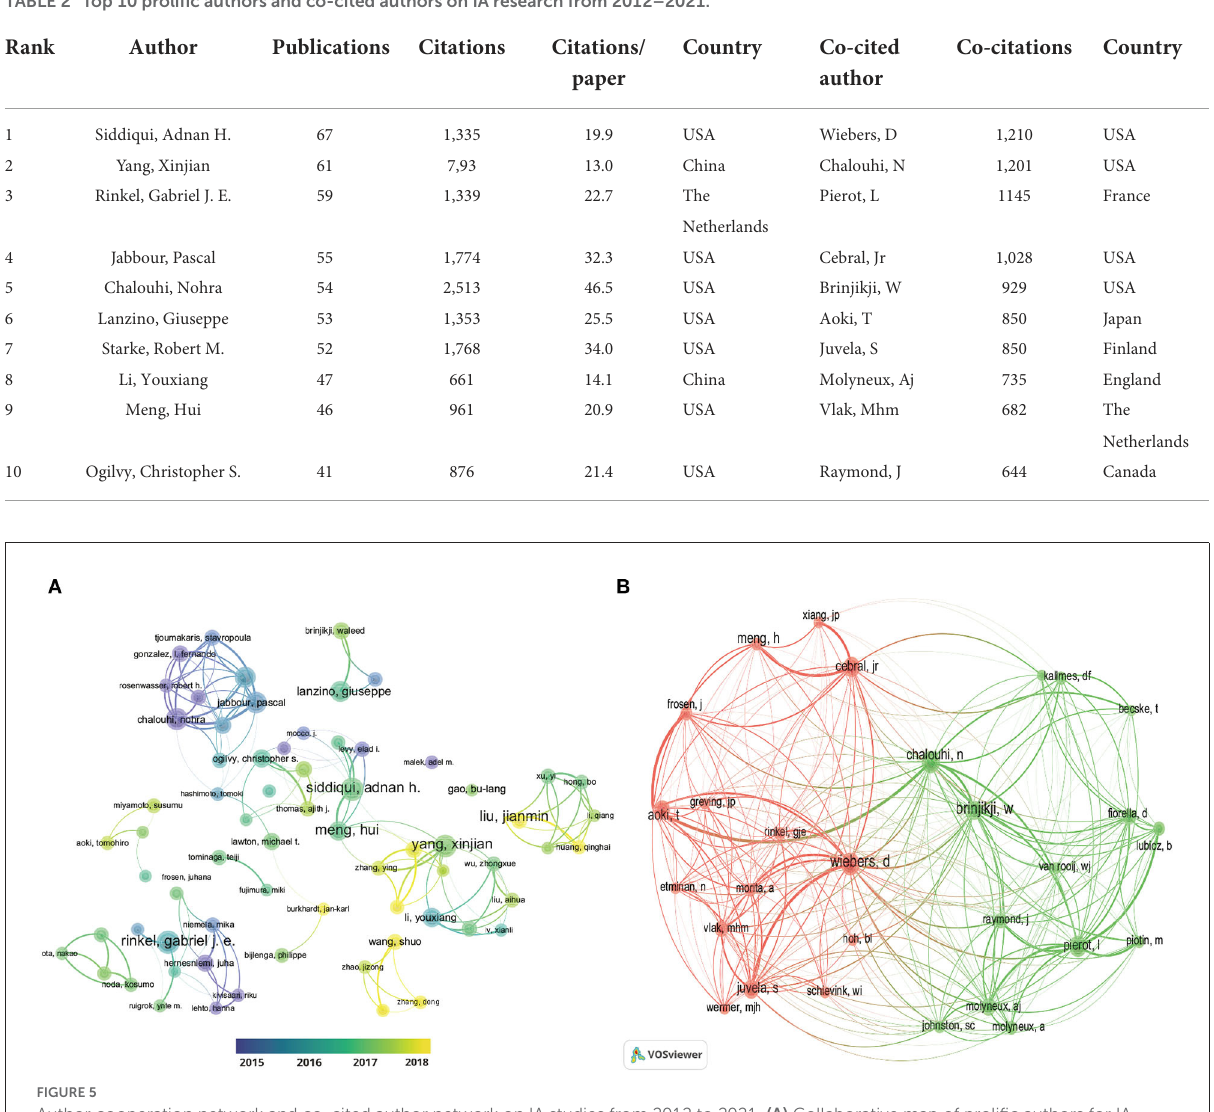
TABLE 2 Top 10 prolific authors and co-cited authors on IA research from 2012–2021.